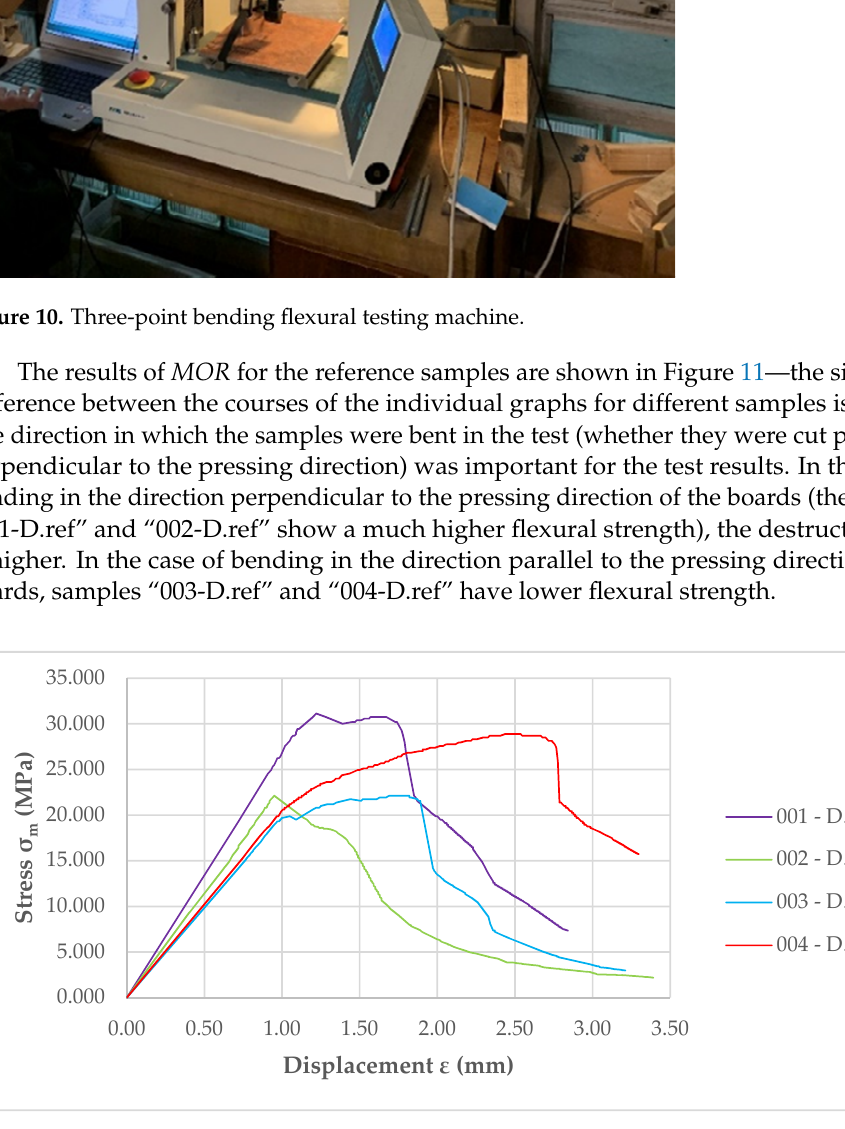
Figure 11. Graph showing the modulus of rupture ( MOR ) of the reference